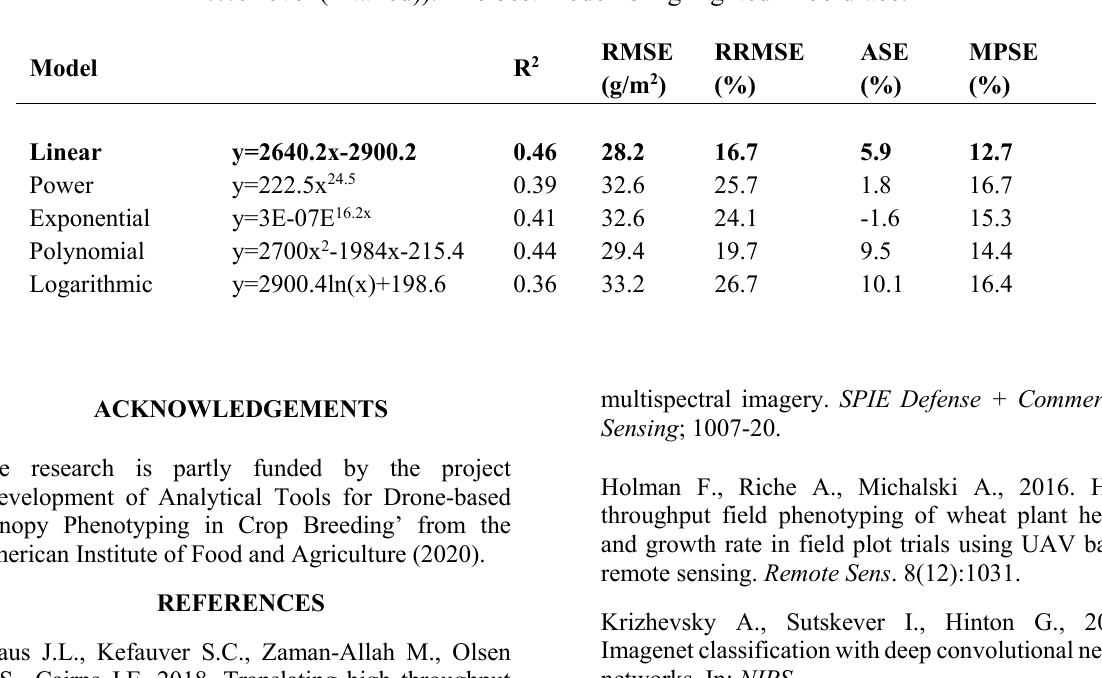
Table 1. Validation statistics of regression models for predicted AGB versus actual AGB (significance at 0.05 level (2-tailed)). The best model is highlighted in